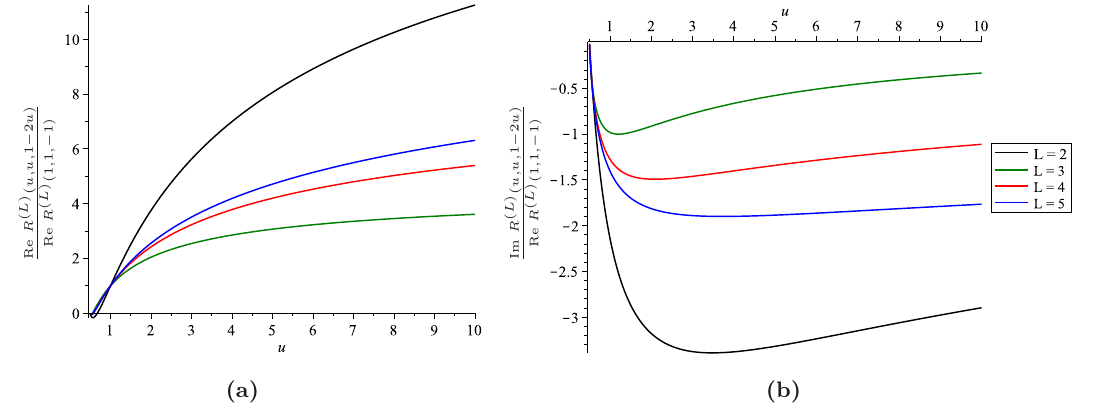
Figure 3. Real (a) and imaginary (b) part of the L -loop form factor remainder function R ( L ) on the line ( u, u, 1 − 2 u ) in scattering region IIa, u > 1 / 2 , normalized by the value of its real part at u = 1